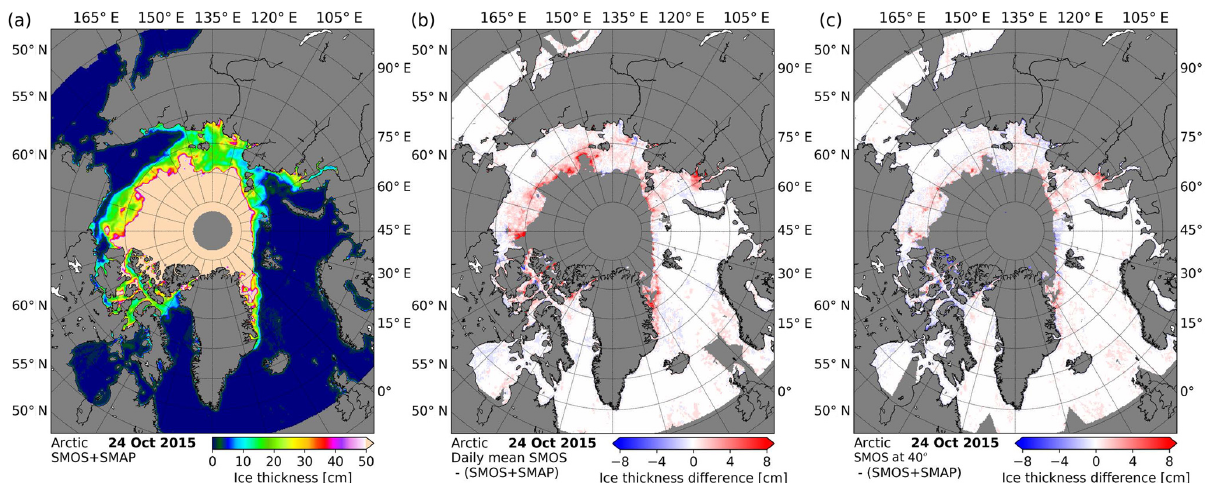
Figure 6. Sea ice thickness retrieved on 24 October 2015 for the joint SMOS–SMAP product (a) , the SIT difference between the SMOS daily mean retrieval and the joint retrieval (b) and the SIT difference between SMOS fitted TBs at the 40 ◦ incidence angle and the joint retrieval (c)